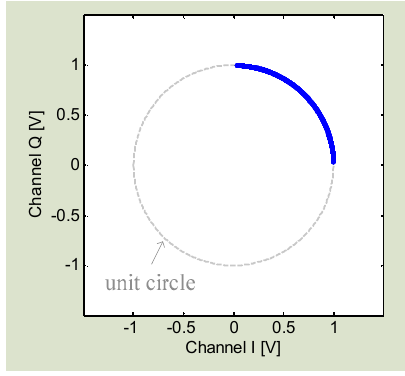
Figure 4. I / Q signals form an arch fitting with the unit circle in I / Q plane.